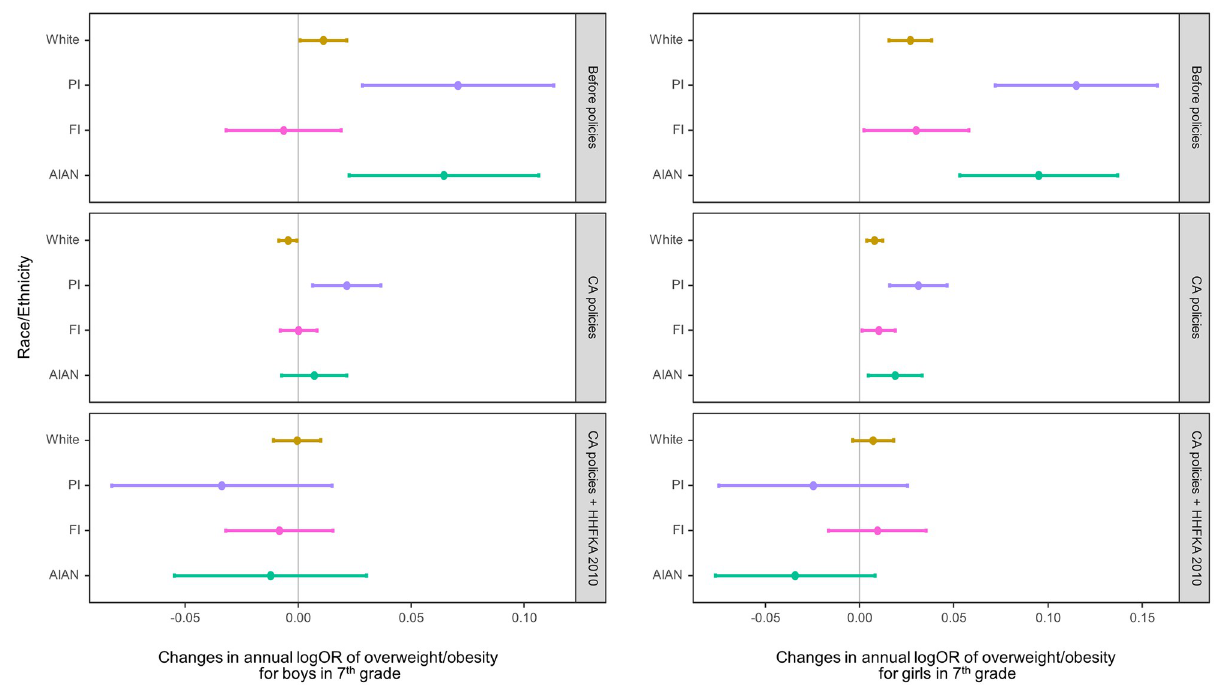
Fig 3. Adjusted change in the log odds of overweight/obesity per year within the periods 2002–2004 (baseline, no policies in effect), 2005–2012 (after CA policies and before HHFKA 2010), and 2013–2016 (CA policies plus HHFKA 2010) among seventh graders by sex. The dots indicate the point estimates of the yearly changes in the log odds, and the whiskers show the 95% confidence intervals. AIAN, American Indian/Alaska Native; CA, California; FI, children of Filipino origin; HHFKA 2010, Healthy, Hunger-Free Kids Act of 2010; OR, odds ratio; PI, children of Pacific Islander origin; W,